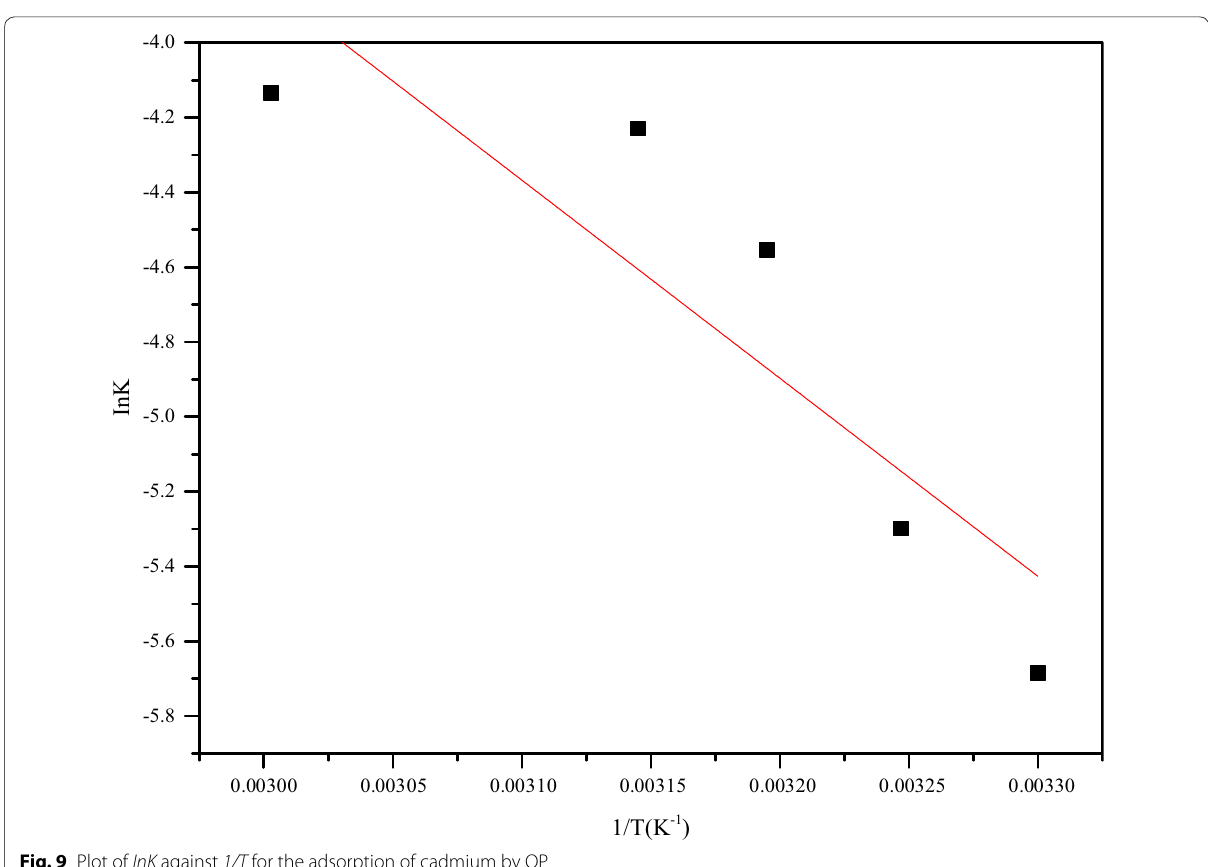
Fig. 9 Plot of InK against 1/T for the adsorption of cadmium by